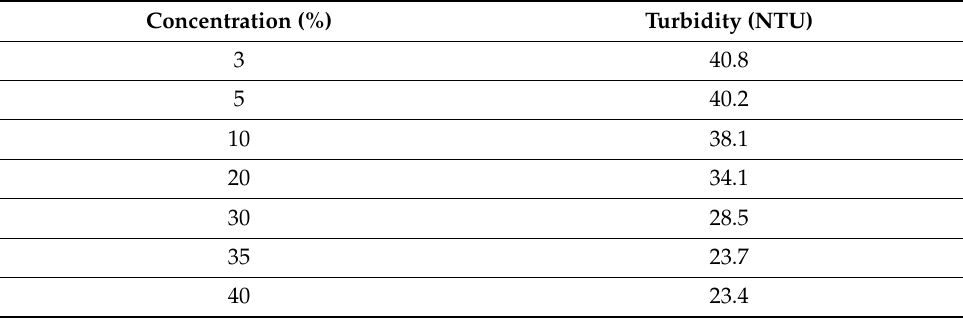
Table 3. Turbidity value for as-synthesized surfactant with the presence of DGME. Concentration